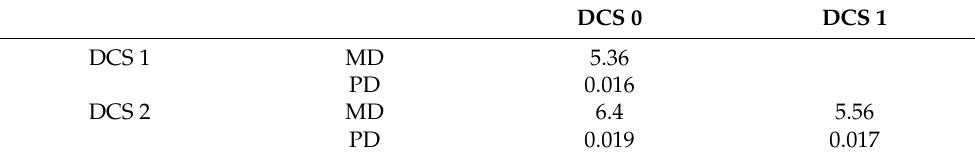
Table 6. Mahalanobis distances (MD) and Procrustes distances (PD) among the dental condition score (DCS) categories (DCS 0, DCS 1, and DCS